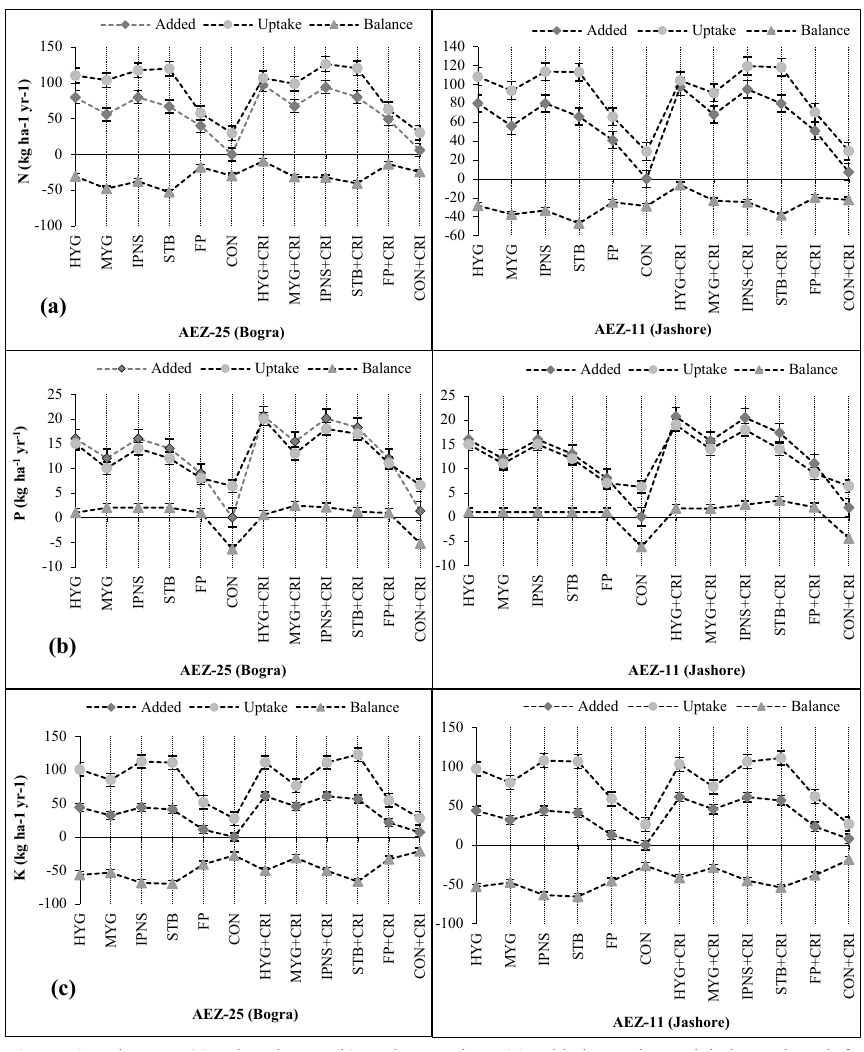
Figure 2: Nitrogen (a), phosphorus (b) and potassium (c) added, uptake and balance in rainfed monsoon rice fields in two locations (AEZ-25 & AEZ-11) of Bangladesh after two years of nutrient management. Mean (±SD) was calculated from three replicates for each treatment and significantly different at P ≤ 0.05 (LSD test). HYG’; High Yield Goal, ‘MYG’; Moderate Yield Goal, ‘IPNS’; Integrated Plant Nutrient System, ‘STB’; Soil Test Based, ‘FP’; Farmer’s Practice, ‘CON’; without fertilizers, ‘CRI’: crop residue incorporation; N, Nitrogen; P, phosphorus; K, potassium.